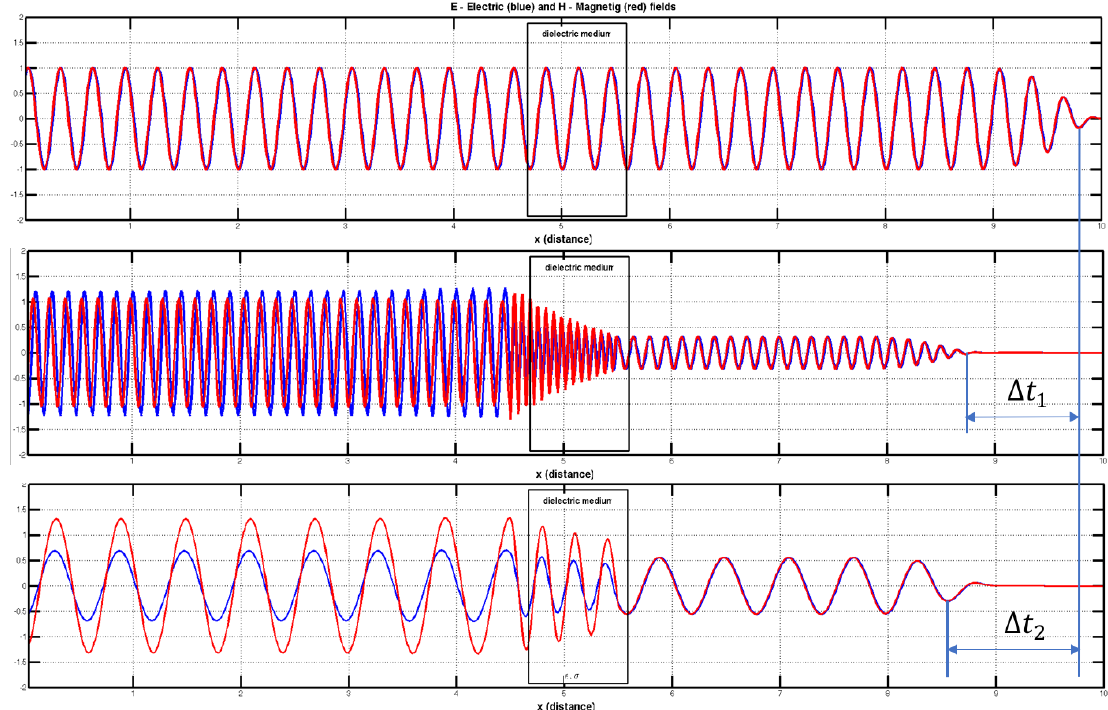
Figure 3. Multifrequency FDTD simulation in a dielectric medium. Transparent ( (cid:101) ef f = 1) for the first frequency at the top. Different interaction (propagation speed and energy absorption) for other frequencies with different (cid:101) ef f . Time differences ∆ t 1 and ∆ t 2 can be measured to analyze dielectric